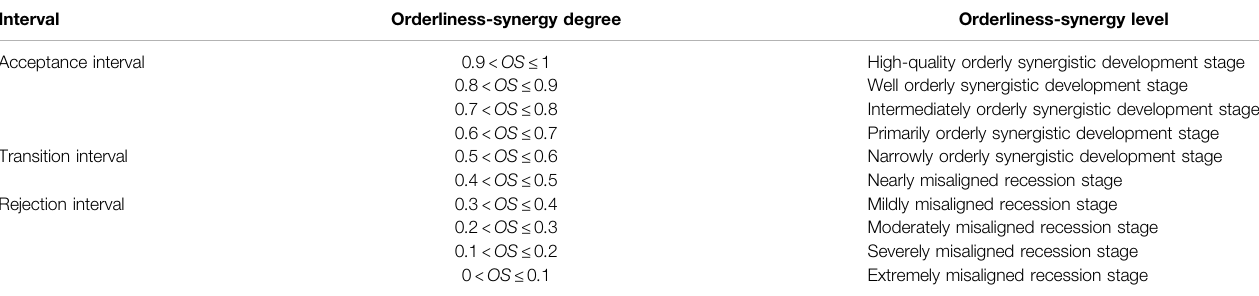
TABLE 2 | Classi fi cation of industrial orderliness-synergy degree. Interval Orderliness-synergy degree Orderliness-synergy level Acceptance